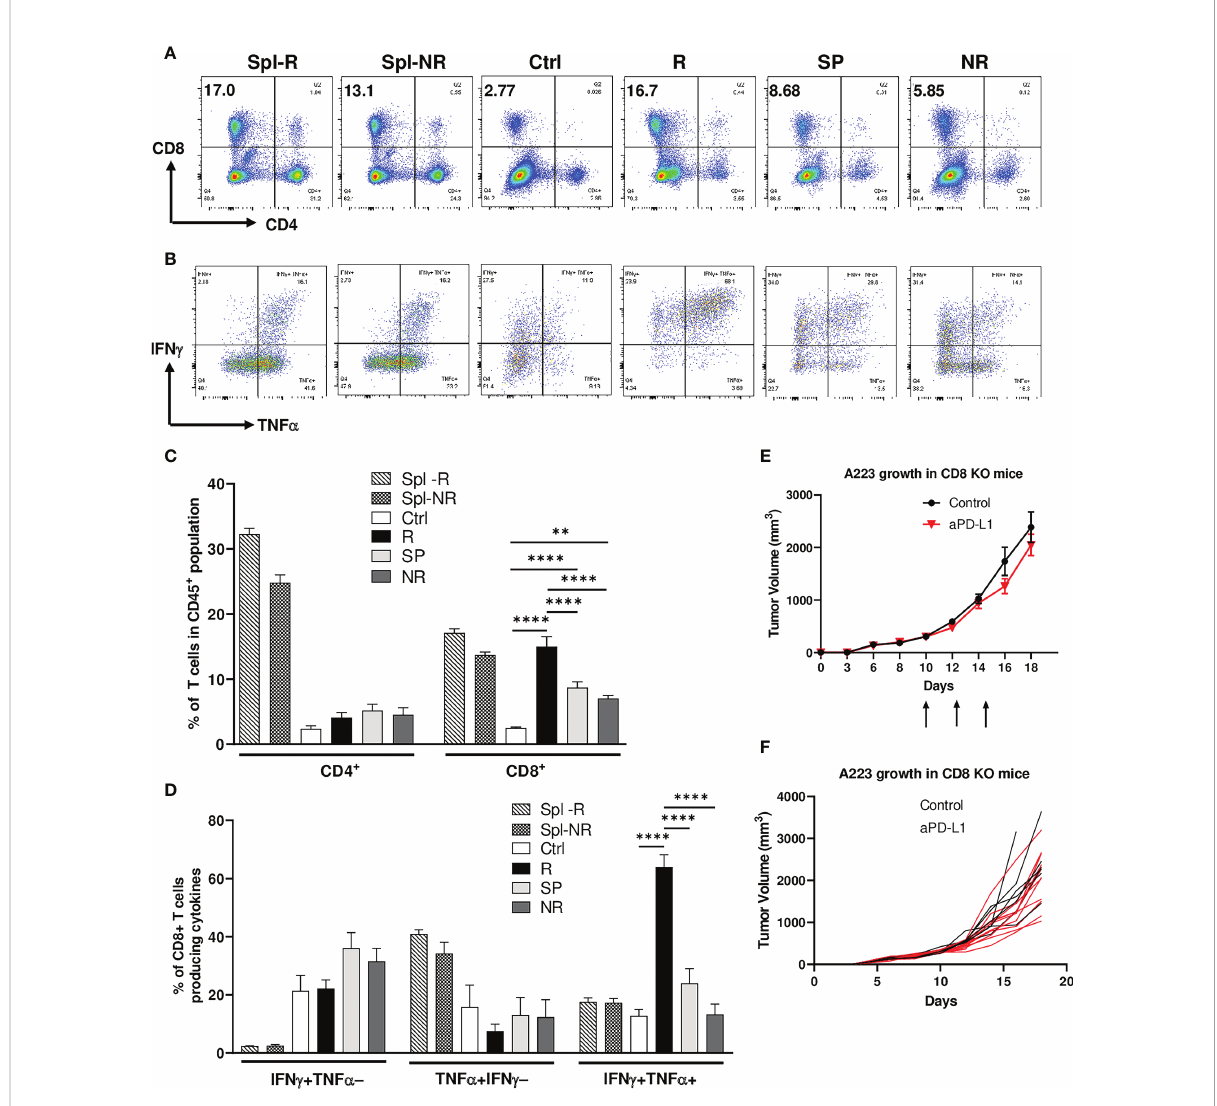
FIGURE 2 Ef fi cacy of anti-PD-L1 treatment depends on CD8 T cells. Tumor-bearing recipients were treated as indicated on day 14, 16 and 18 after tumor inoculation. Spleens and tumors were harvested on day 21 after inoculation. Cells were stained and analyzed by fl ow cytometry. (A, C) Correlation of CD8 TIL percentage with anti-PD-L1 responses. Representative fl ow plots (A) and percentages (C) of CD4 and CD8 T cells within CD45 + population of splenic samples from responder (R) (Spl-R, n=5) or non-responder (NR) mice (Spl-NR, n=6), or tumor samples from control (Ctrl, n=9), R (n=5), slow progressor (SP) (n=6) and NR (n=6) mice. (B, D) Correlation of IFN- g /TNF- a -double producing CD8 TILs with anti-PD-L1 responses. Representative fl ow plots (B) and quanti fi cation of the percentages (D) of stimulated CD8 T cells producing IFN g alone (IFN g + TNF a − , top left quadrant in panel B), TNF a alone (TNF a + IFN g − , bottom right quadrant in panel B), or both cytokines (IFN g + TNF a + , top right quadrant in panel B) in Spl-R (n=5), Spl-NR (n=6), Ctrl (n=9), R (n=5), SP (n=6) and NR (n=6). Data are from a single experiment which are representative of 3 independently repeated cohort experiments. (E, F) Treatment ef fi cacy depends on CD8 T cells. A223 tumors (1×10 5 cells) were injected s.c. into one fl ank of CD8 -/- mice. When tumor size reached ~300mm 3 , recipients were treated with control (n=7) or anti-PD-L1 (n=11). Tumor growth was monitored for 18 days. Overall (E) or individual (F) tumor growth curves of control and anti-PD-L1 treated recipients. Data were presented as mean ± SEM. Statistical signi fi cance was calculated with one-way ANOVA followed by Tukey ’ s multiple comparisons test (**, P <0.01; ****, P